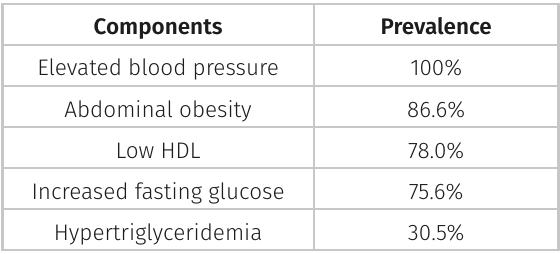
Table II. Prevalence of components of the metabolic syndrome in patients with established atherosclerosis disease in Pelotas, RS,